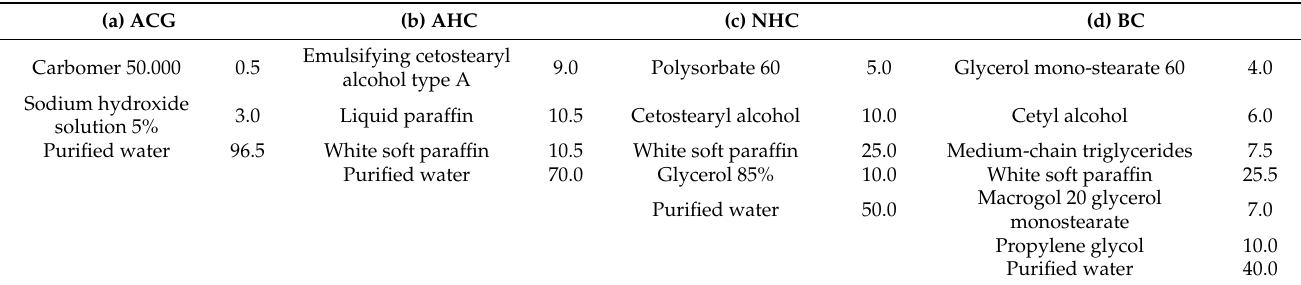
Table 1. Composition (in % w / w ) of the compendial bases without TAA and